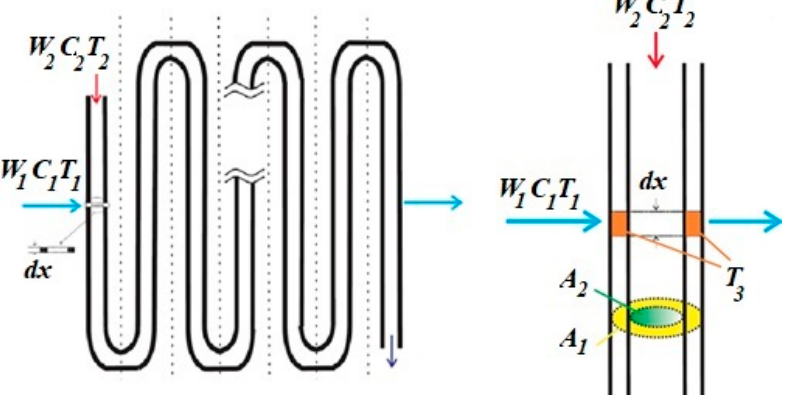
Figure 2. Sketch of a coil and a detail with the main state variables and parameters.